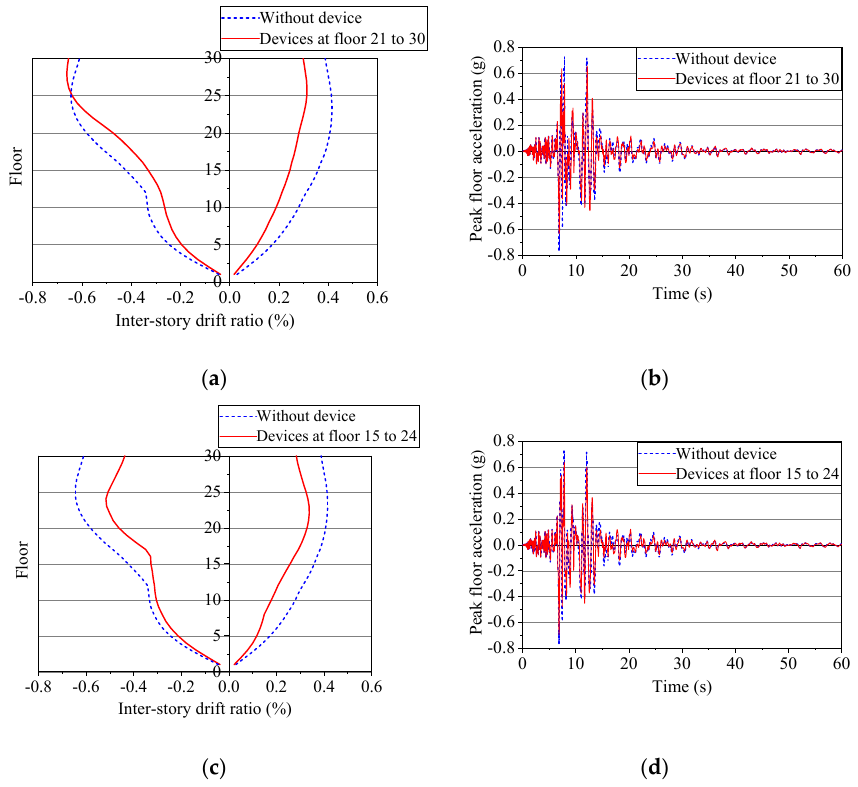
Figure 22. Behavior of structures: ( a ) Inter-story drift and ( b ) Floor acceleration on 30th floor: devices on floors 21 to 30; ( c ) Inter-story drift and ( d ) Floor acceleration on 30th floor: devices on floors 15 to 24.